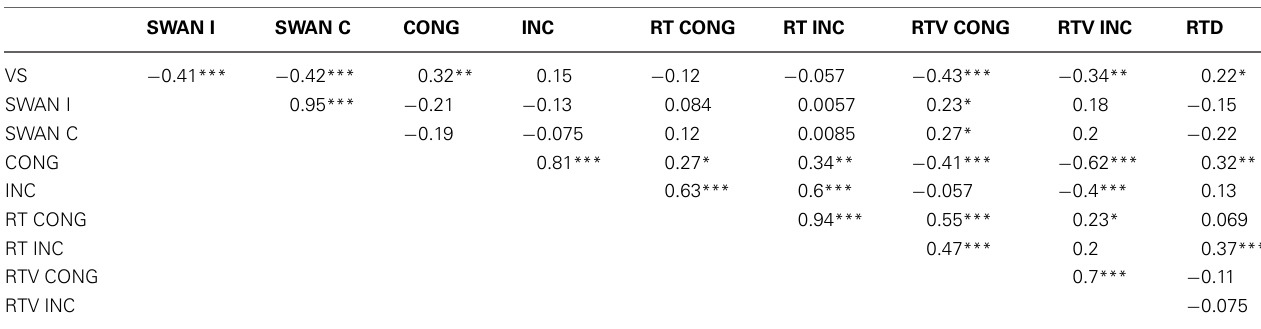
Table 2 | Correlation